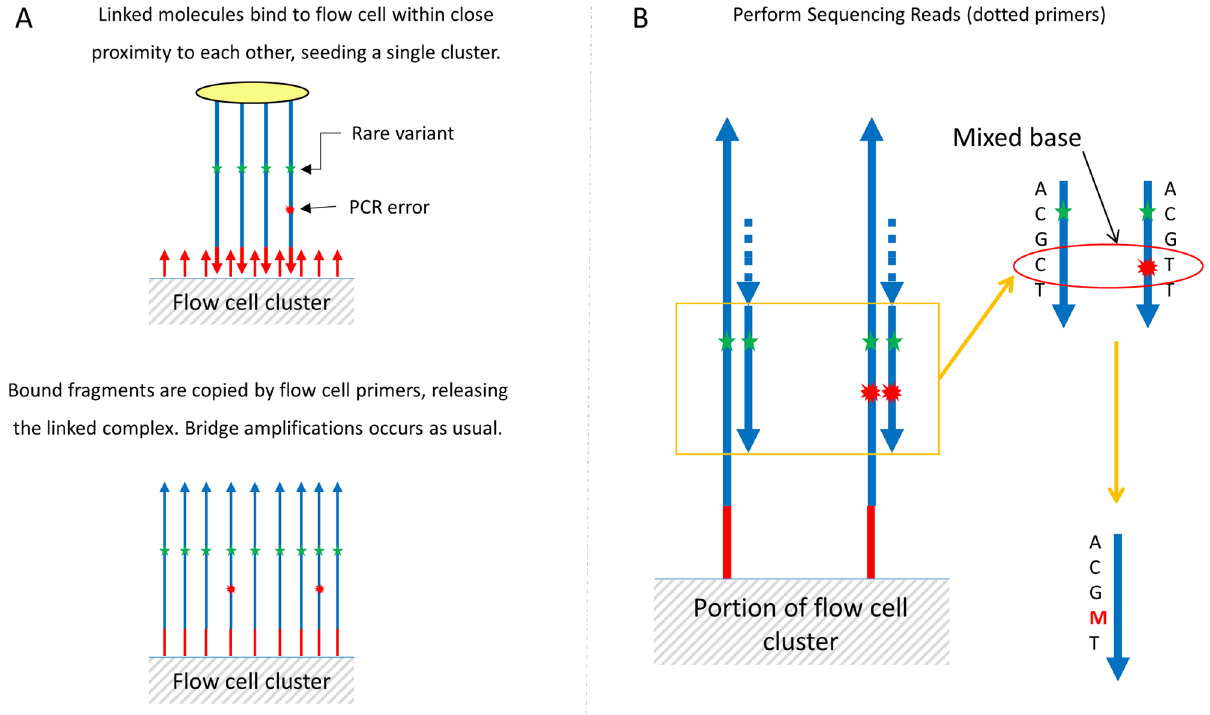
Fig 2. Pro-Seq sequencing. (A) Linked molecules are bound to the flow cell in close proximity to each other and form a single cluster as the size scale of the linker is much smaller than the size of a cluster. Following standard cluster generation, the bound fragments are extended and the linked template washed off (they do not interfere with flow cell function). After extension, bridge amplification proceeds as normal, with each cluster represented by multiple copies of the same starting molecule. (B) Clusters are sequenced, automatically generating an average or consensus of each base position, eliminating errors that occur as a small fraction of a cluster. In the case where the error signal is of similar scale to the true signal, error positions can be identified as mixed bases and masked (‘M’).